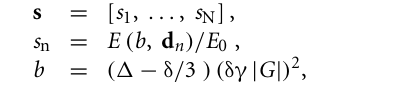
FIGURE 1 | lop-DWI: sampling and filtering . (A) Evenly distributed spiral samples over the unit sphere, (B) periodic spiral sampling over the unit sphere, sampled with 20° azimuthal angular velocity, (C) noise-free and noisy diffusion-weighted signals of a given voxel of the phantom in the gradient